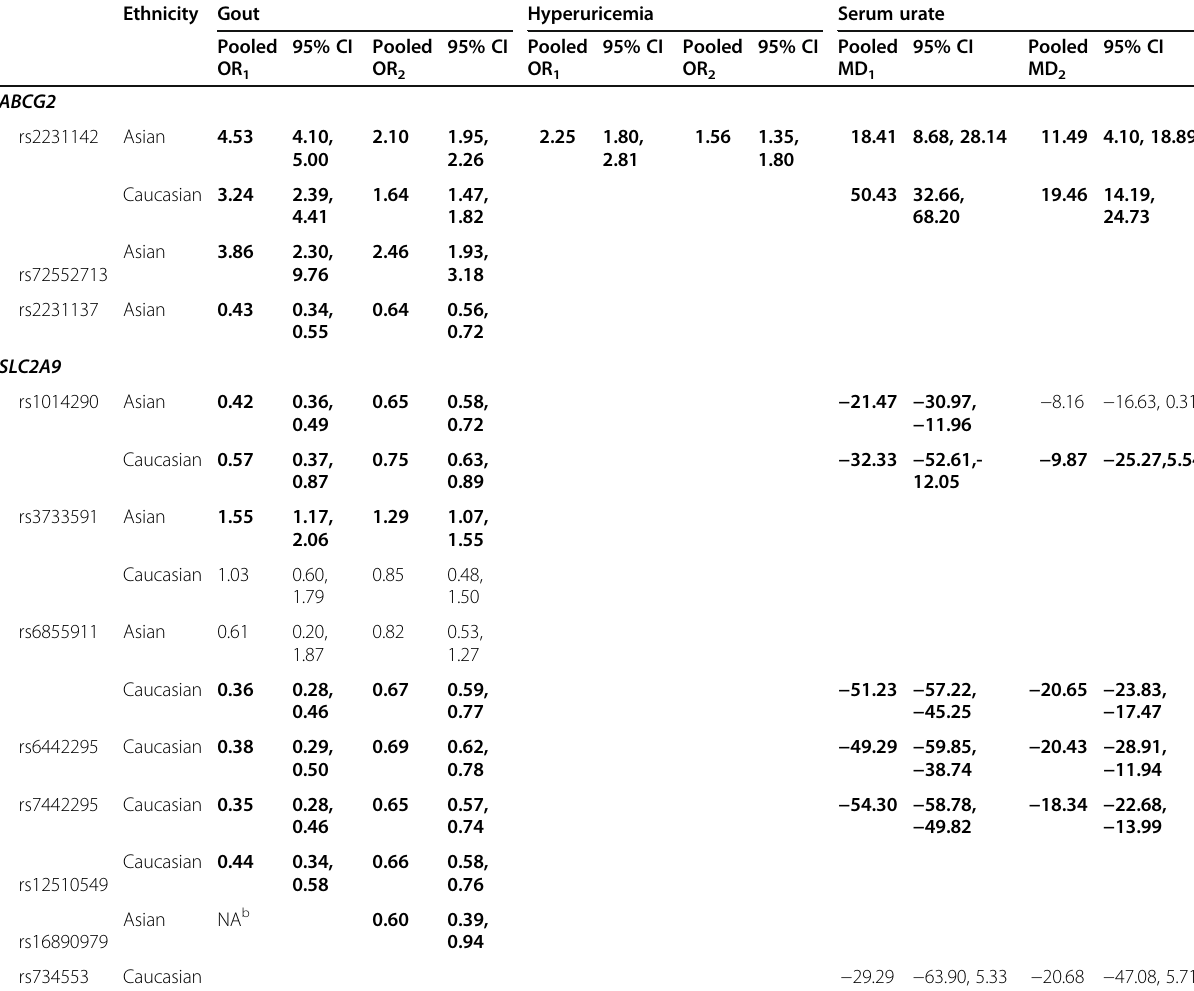
Table 3 Summary of pooled effect sizes of ABCG2 and SLC2A9 polymorphisms on all outcomes